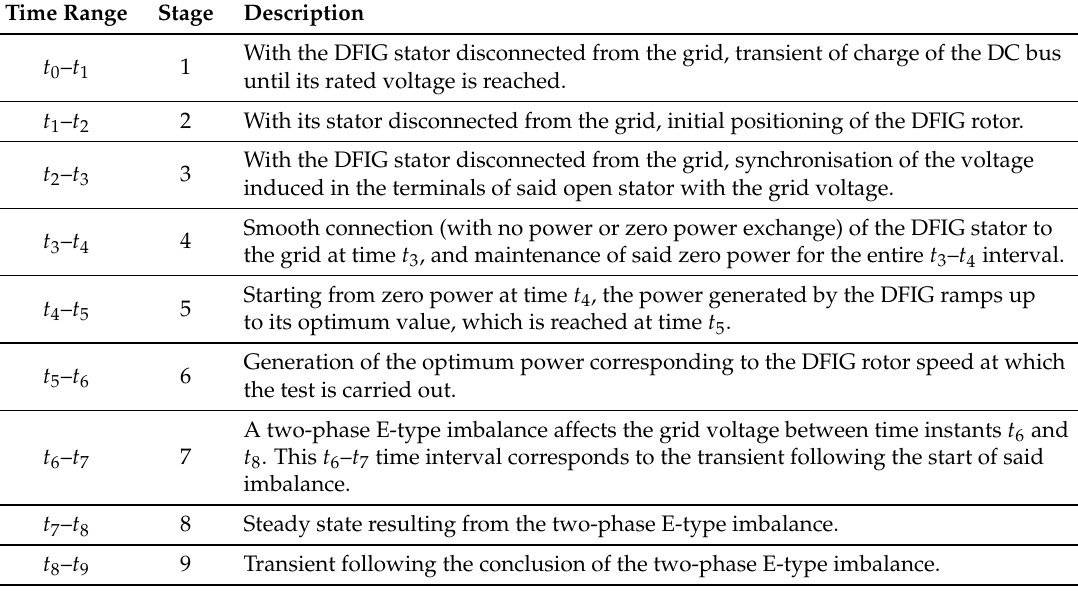
Table 3. Values for the time instants delimiting the stages of the designed test.